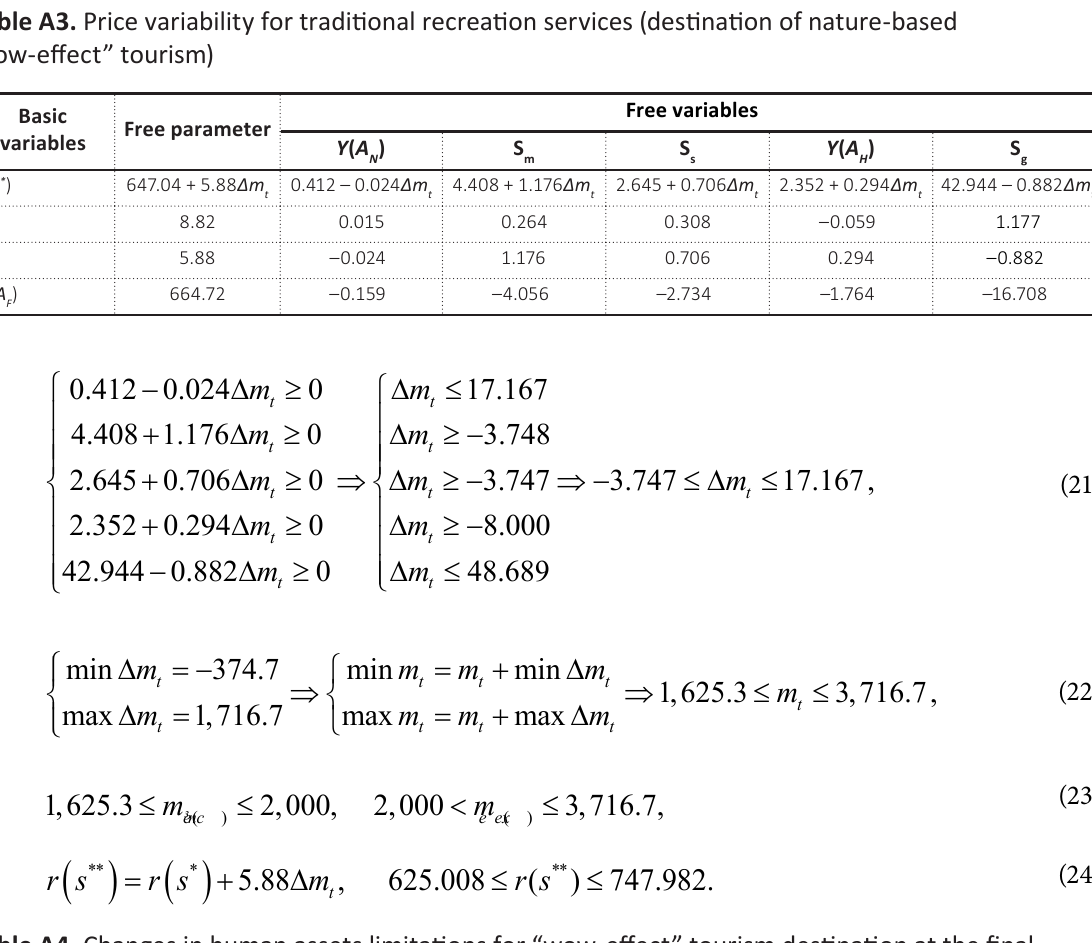
Table A4. Changes in human assets limitations for “wow-effect” tourism destination at the final iteration of programming